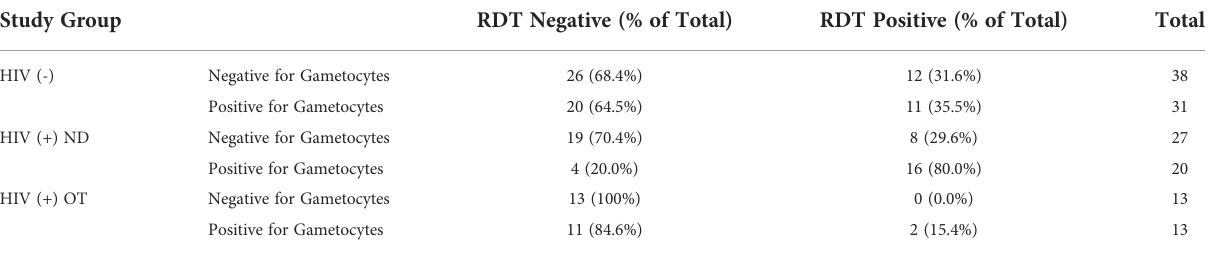
TABLE 4 Comparison of Gametocyte Positivity at Month 0 by RDT positivity and Study Group. Study